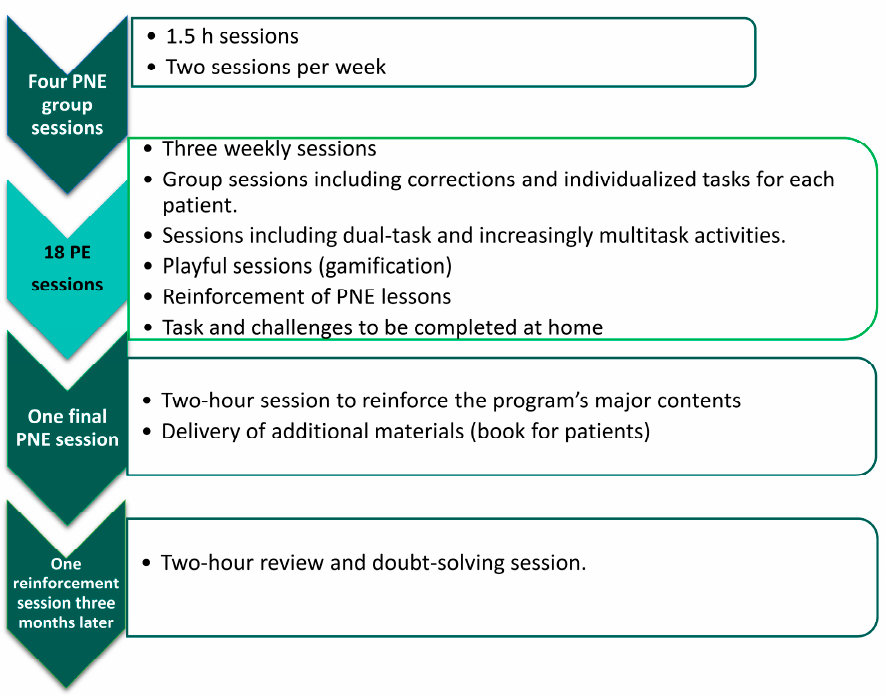
Figure 1. Distribution of the program followed by the experimental group.